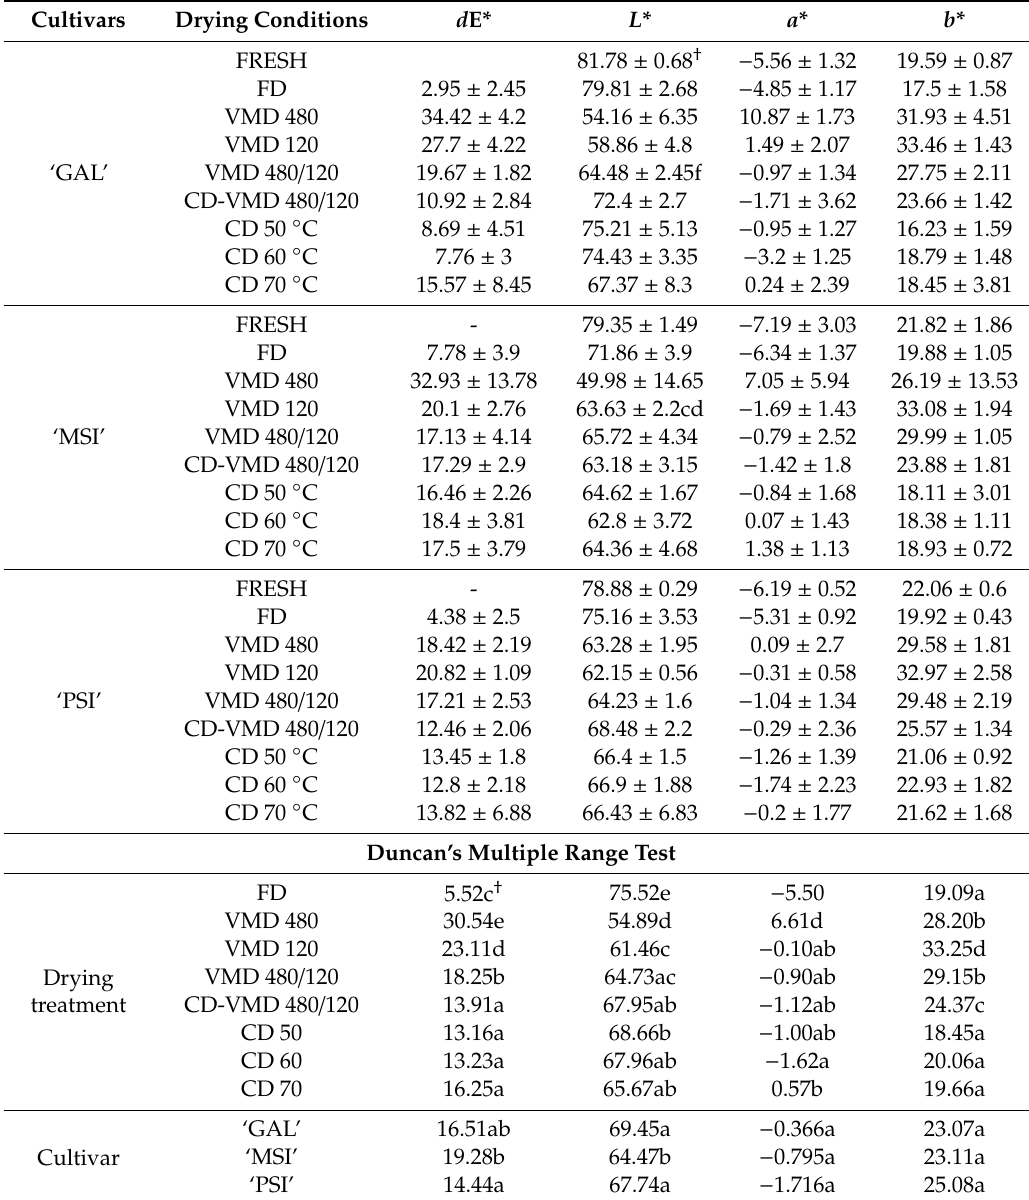
Table 2. Colour parameters as a ff ected by di ff erent drying methods of jujube fruits.